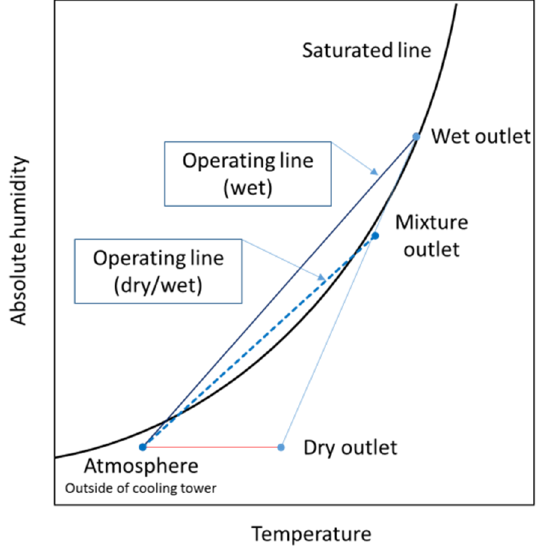
Figure 2. Schematic diagram of an air chart, describing the operating lines of a cooling tower.